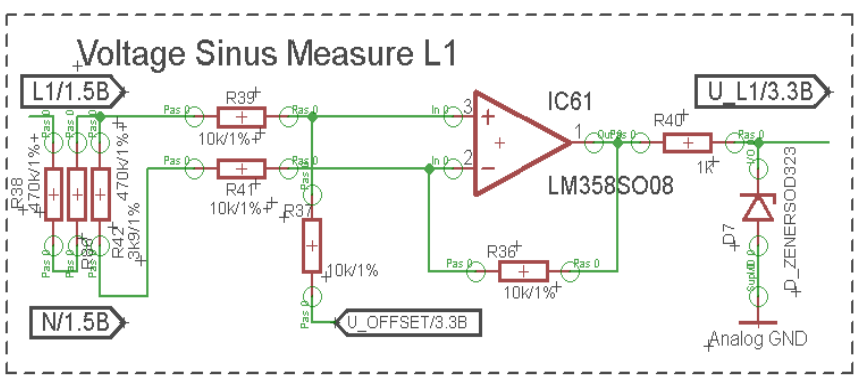
Figure 3. Input voltage level